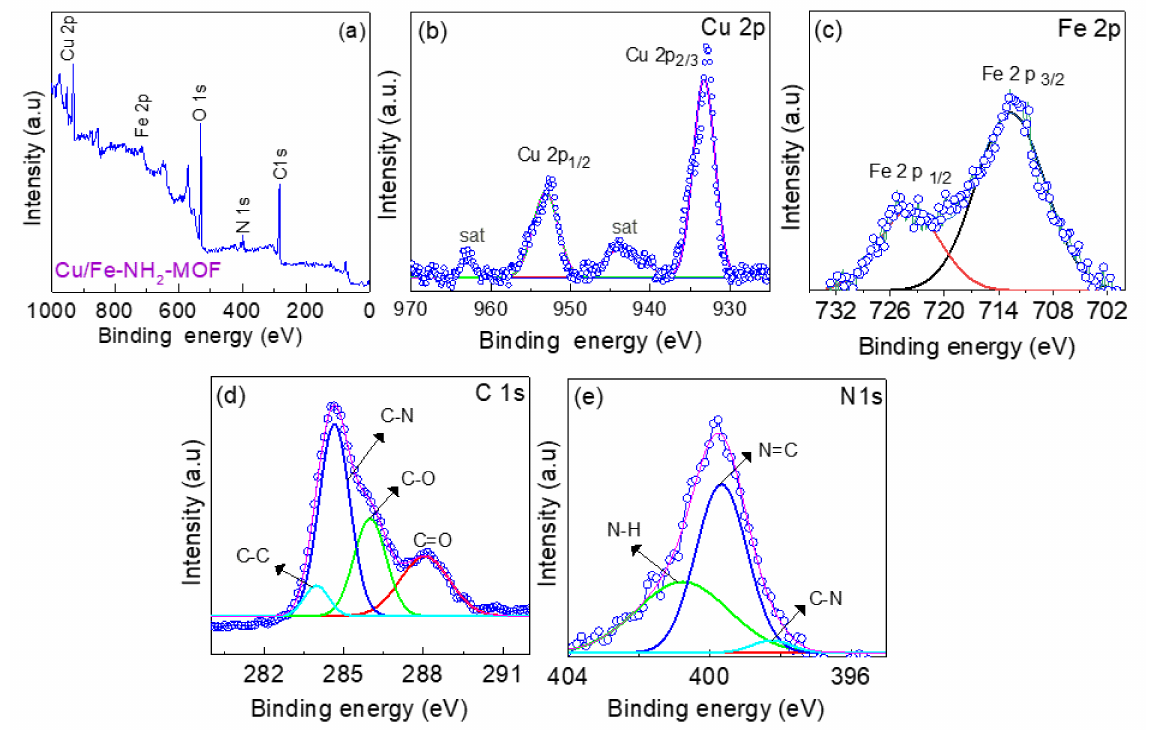
Figure 4. ( a ) XPS survey spectrum, and high-resolution XPS spectrum of ( b ) Cu 2p ( c ), Fe 2p ( d ) C 1s, and ( e ) N 1s of the drop-casted Cu/Fe-MOF film (Blue open circles represent experimental data and solid purple, red, green, blue and sky-blue lines represent corresponding fitting